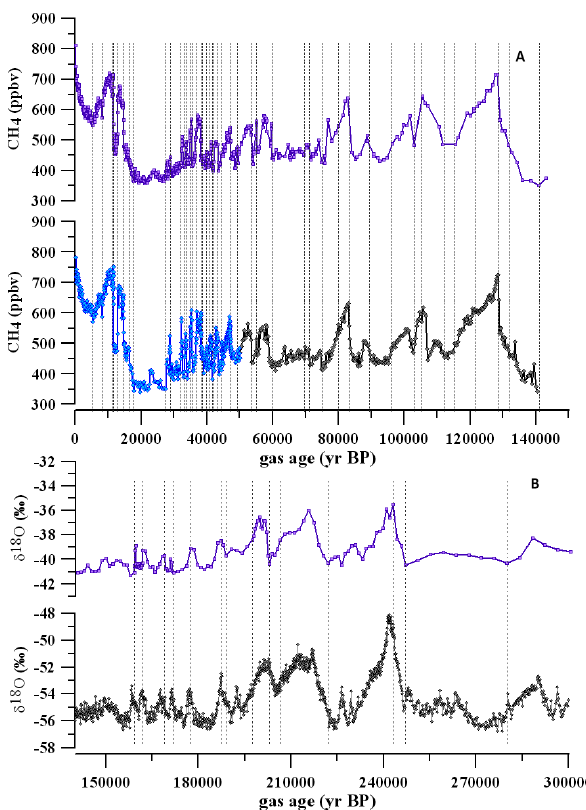
Fig. 1. ( A) : Synchronization of the TALDICE CH 4 record (purple curve) with the Greenland CH 4 composite on GICC05 age scale (Blunier et al., 2007) (blue curve) back to 53kyr BP, and with the EDC CH 4 record (grey curve) on EDC3 age scale (Loulergue et al., 2008) for ages older than 53kyr BP. ( B) : Synchronization between TALDICE (Stenni et al., 2011) (purple curve) and EDC (grey curve) ice cores on the EDC3 age scale (EPICA Community Members, 2004) using δ 18 O of ice. For both graphs, dashed lines indicate the location of each tie point.